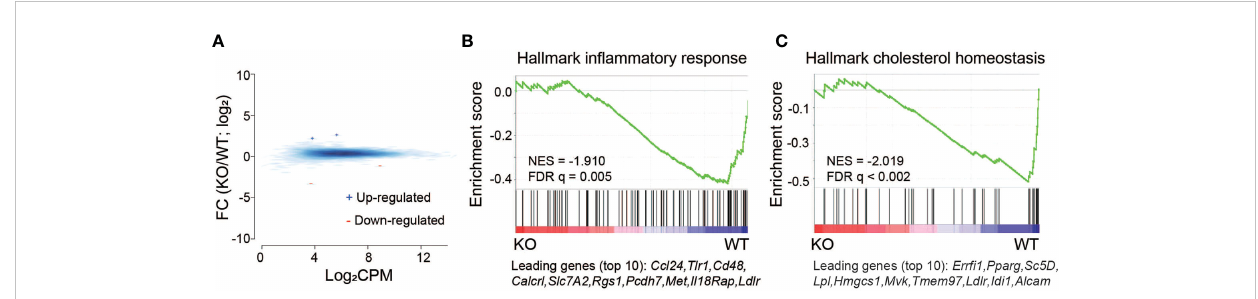
FIGURE 3 Basal level transcriptional changes induced by IL-27R a depletion without E. coli infection. (A) MA plot for genes differentially expressed in spleen between IL-27R a depletion (KO) and wild-type control (WT). Blue +: genes upregulated by IL27R a KO; red -: genes down-regulated by IL27R a KO. Blue smoothed heat map: all expressed genes. (B) GSEA analysis for expressed genes ranked by fold change of expression (KO/WT) against the MSigDB Hallmark gene set “ in fl ammatory response ” , with top 10 down-regulated genes shown at the bottom. (C) GSEA analysis for expressed genes ranked by fold change of expression (KO/WT) against the MSigDB Hallmark gene set “ cholesterol homeostasis ” , with top 10 down-regulated genes shown at the